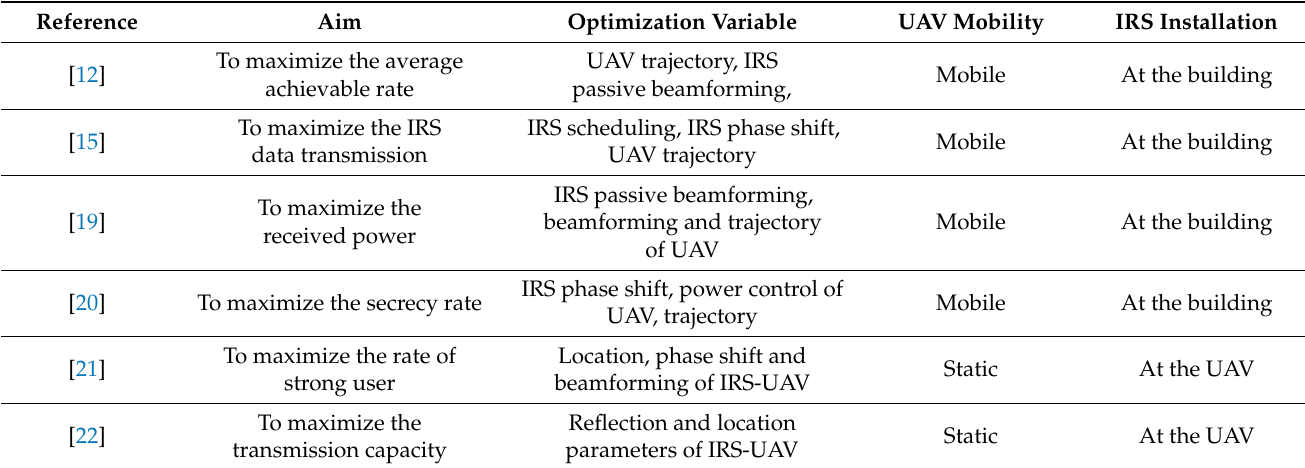
Table 1. Existing works combining UAV and